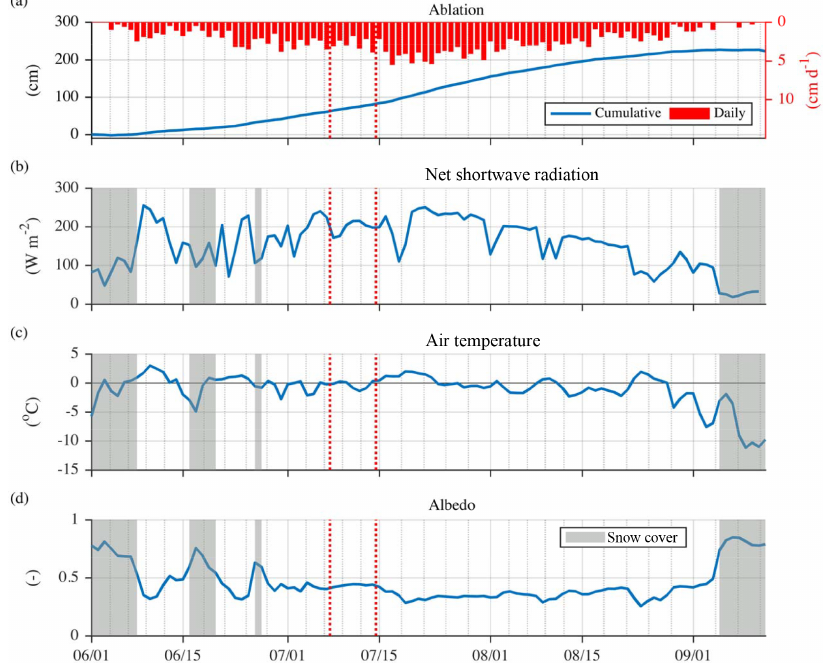
Figure 8. Meteorological records of (a) daily and cumulative ice surface ablation, (b) net shortwave radiation, (c) 2m air temperature, and (d) albedo, for the period 1 June 2016–15 September 2016. Data were collected by the PROMICE/GAP KAN-M automatic weather station (see Fig. 2 for location). Vertical grey shaded bars indicate time periods when albedo was greater than >0.5, indicating snow cover was likely present. Albedo is calculated from the ratio of outgoing solar radiation to incoming solar radiation measured ∼ 2m above the ice sheet surface at the KAN-M station (available at: